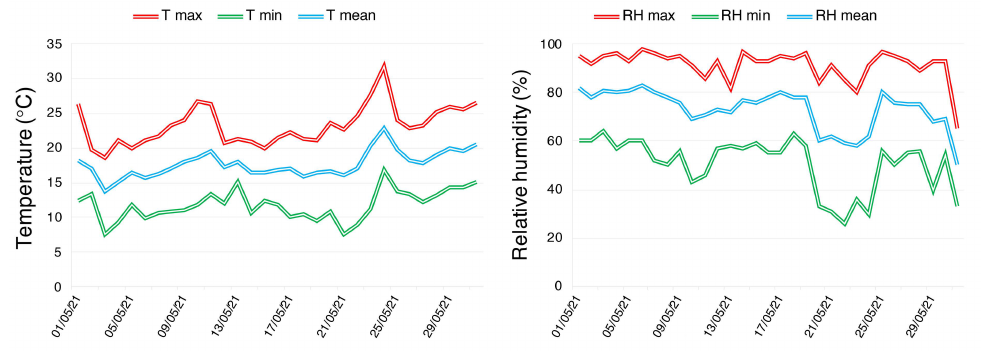
Figure 1. Daily trend of maximum (red line), minimum (green line), and mean (blue line) temperature and humidity measured in May 2021 at “Improsta” Regional Experimental Farm, in Eboli (SA) (40 ◦ 33 (cid:48) 29 (cid:48)(cid:48) N; 14 ◦ 58 (cid:48) 28 (cid:48)(cid:48) E, at 15